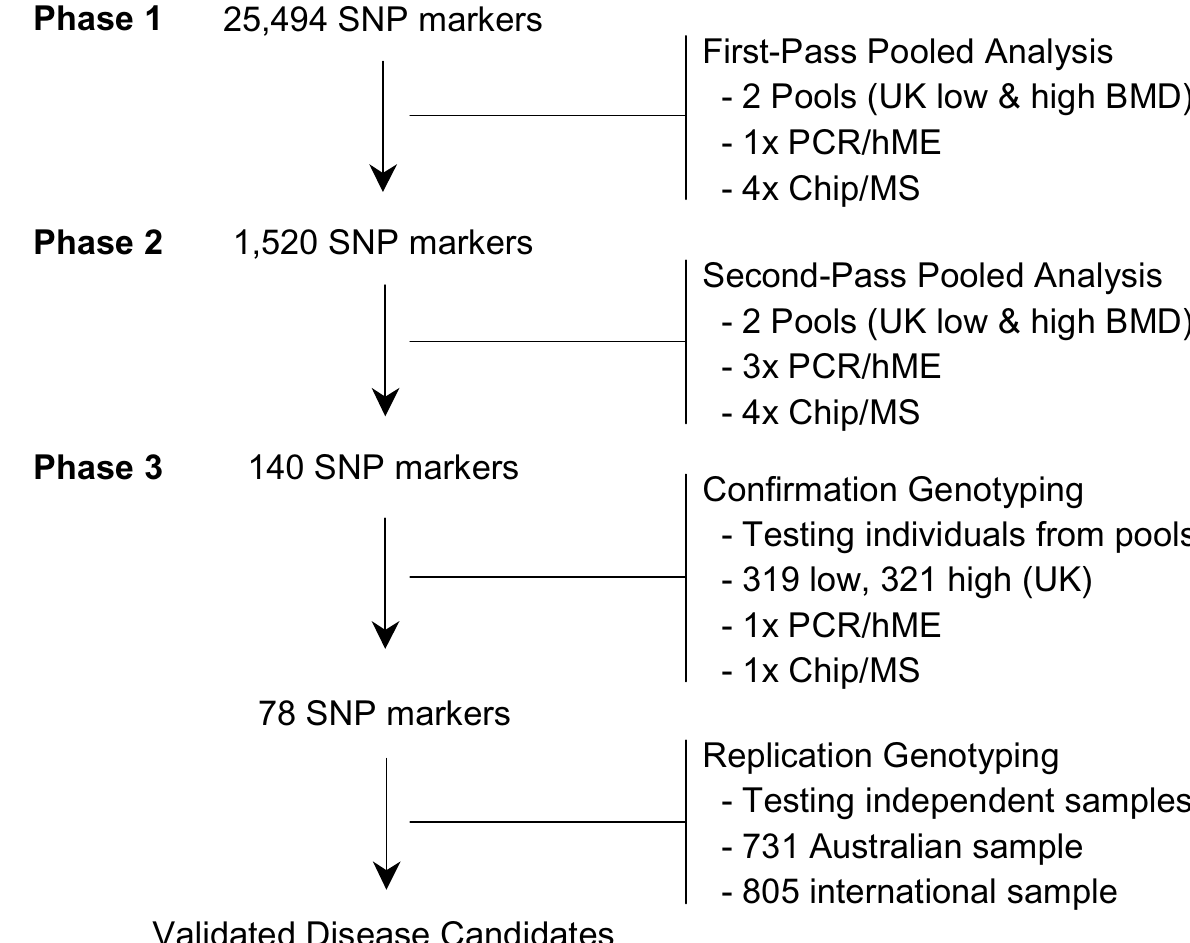
Figure 1 Overview of DNA pool-based large-scale association strategy. Phases 1 and 2 are conducted using DNA pools yielding allele frequencies, all subsequent steps involve genotyping of individual samples. hME, homogeneous MassEXTEND; MS, mass spec- trometry. See text for more